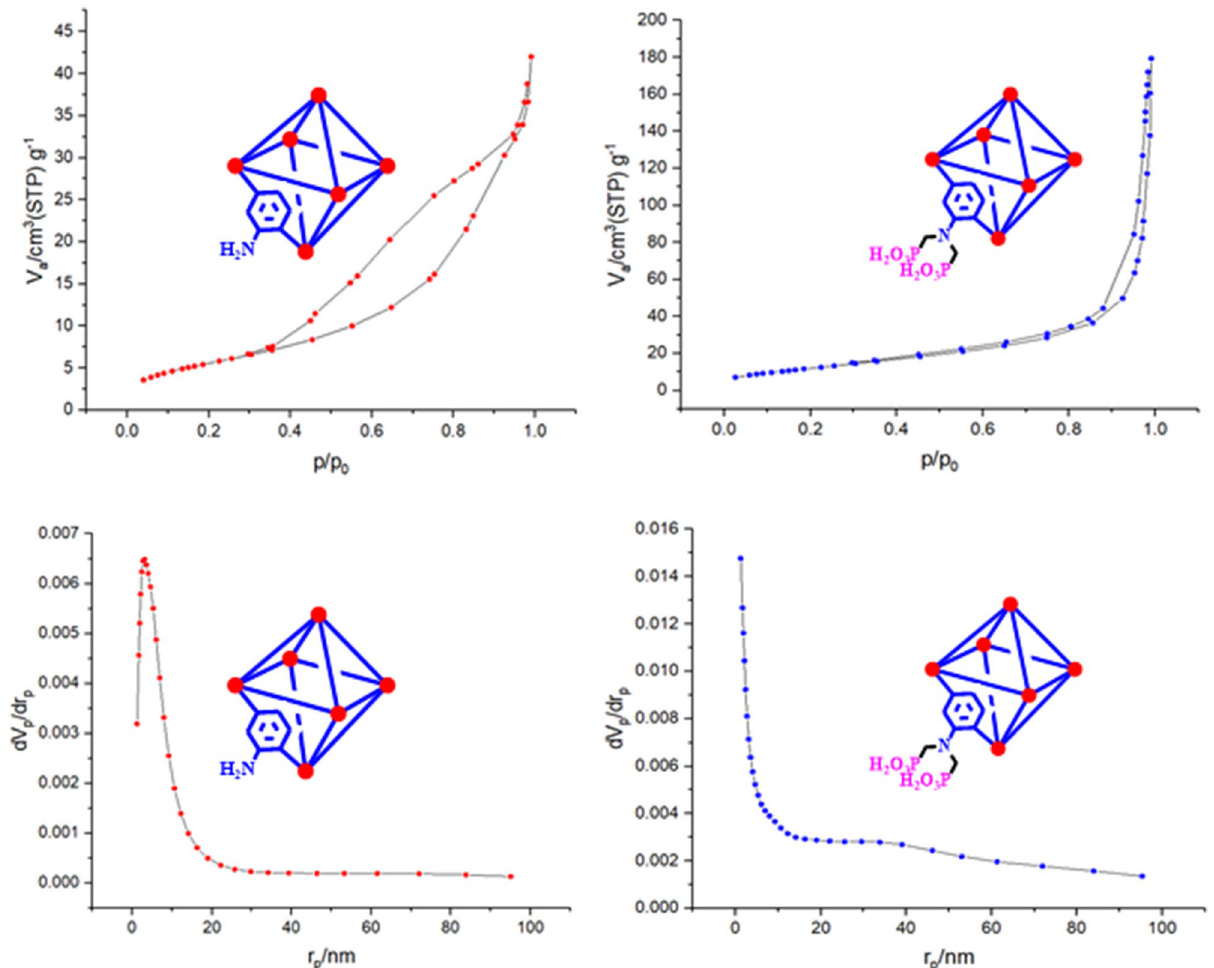
Figure 12. N 2 adsorption/desorption isotherm and BJH of MIL-53(Al)-N(CH 2 PO 3 H 2 ) 2 and MIL-53(Al)- N(CH 2 PO 3 H 2 ) 2